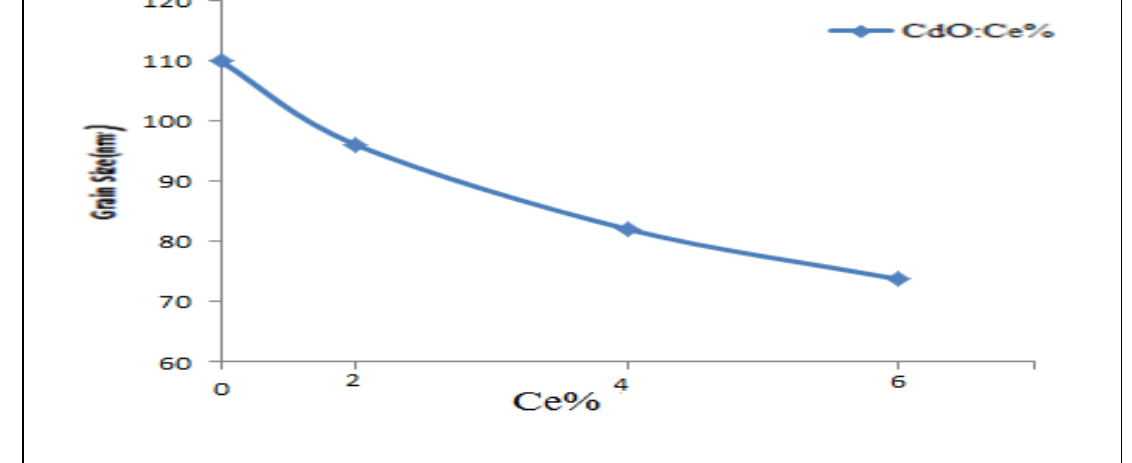
Fig. 5: Variation in grain size with Ce concentration for CdO prepared glass substrates.